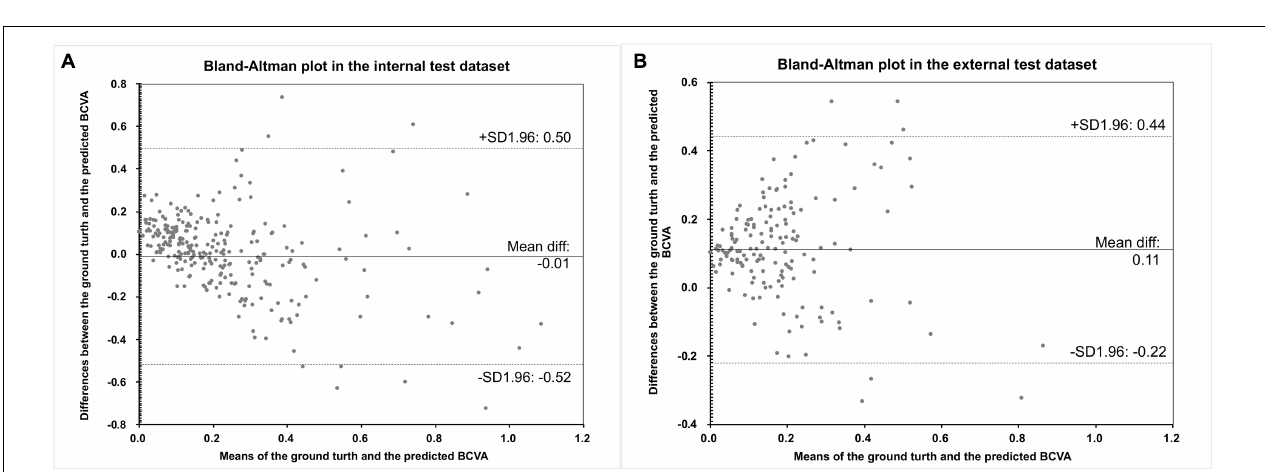
FIGURE 2 | The scatter plots of the predicted BCVA and the actual BCVA (ground truth) in the internal (A) and external (B) test datasets. Representative cases of Grad-CAM visualization in the good VA group (C) and in the poor VA group (D) . Red regions corresponds to highly discriminative areas of OCT scans when predicting the VA. All values were provided in logMAR units. BCVA, best corrected distance visual acuity; logMAR, logarithm of the minimum angle of resolution; Grad-CAM, gradient-weighted class activation mapping.